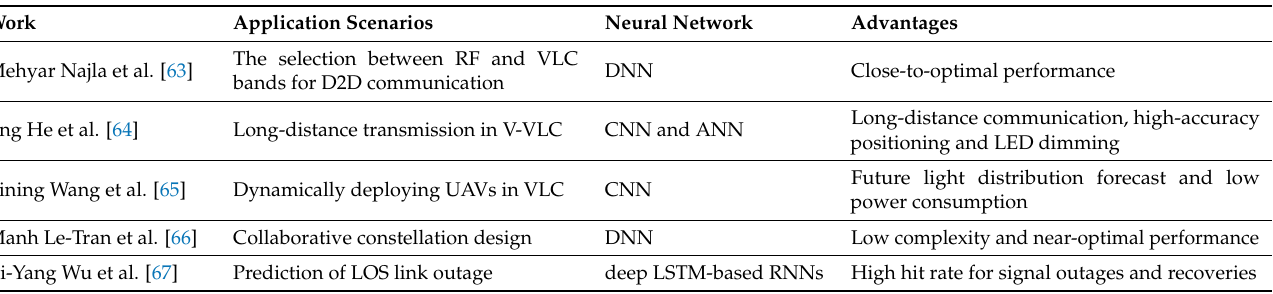
Table 3. Summary of ML applications in